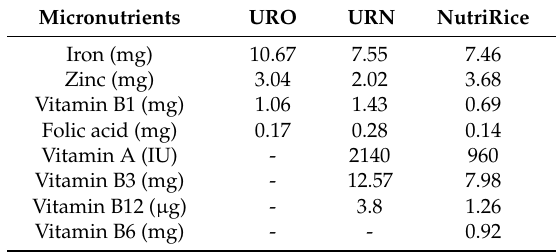
Table 1. Micronutrient contents of the fortified rices per 100 g of uncooked blended rice.